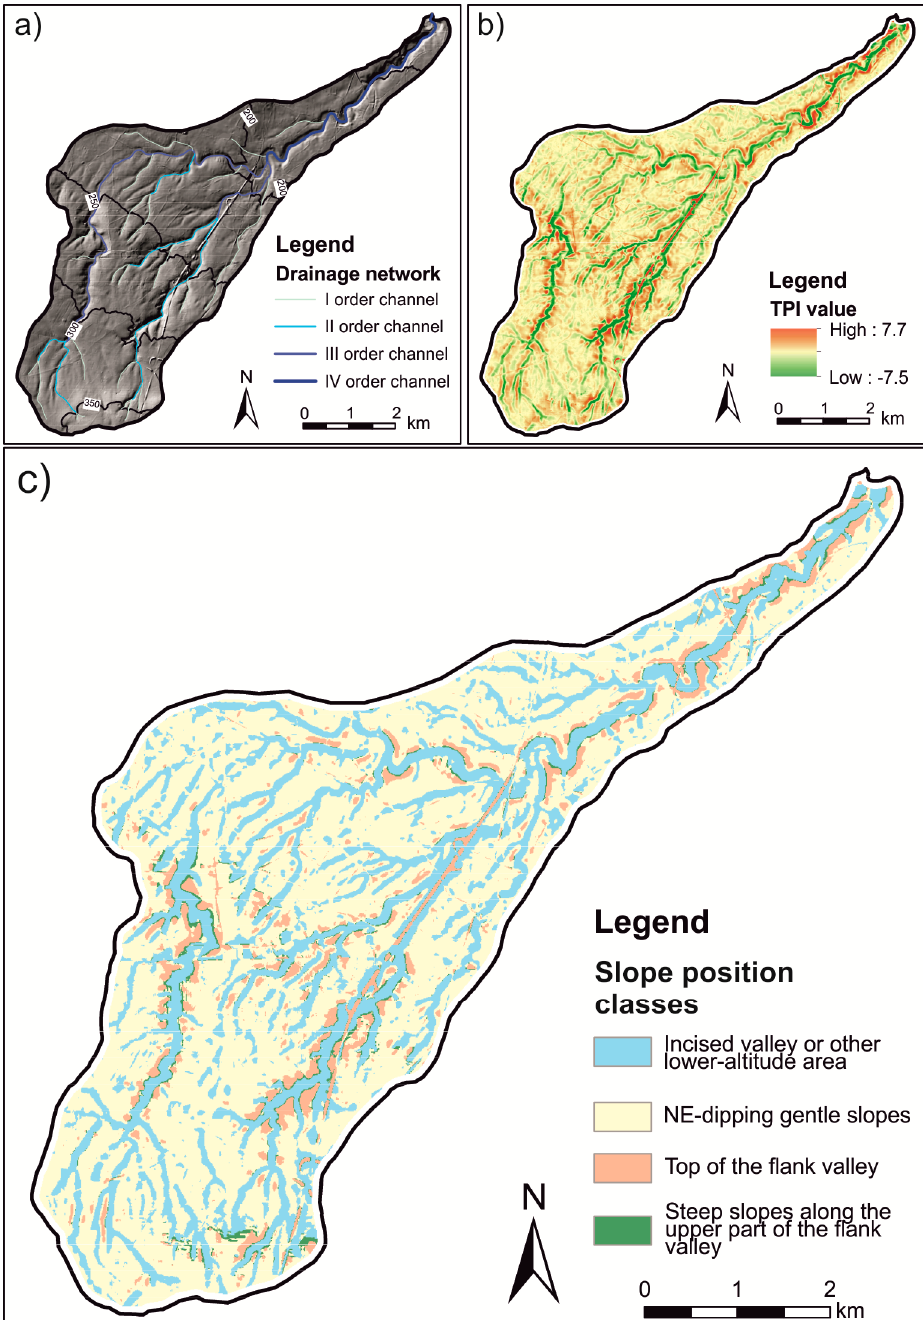
Figure 10. Drainage network ( a ) Strahler’s classification, topographic position index ( b ) and relative landform classification ( c ) of the Lama Lamasinata catchment.